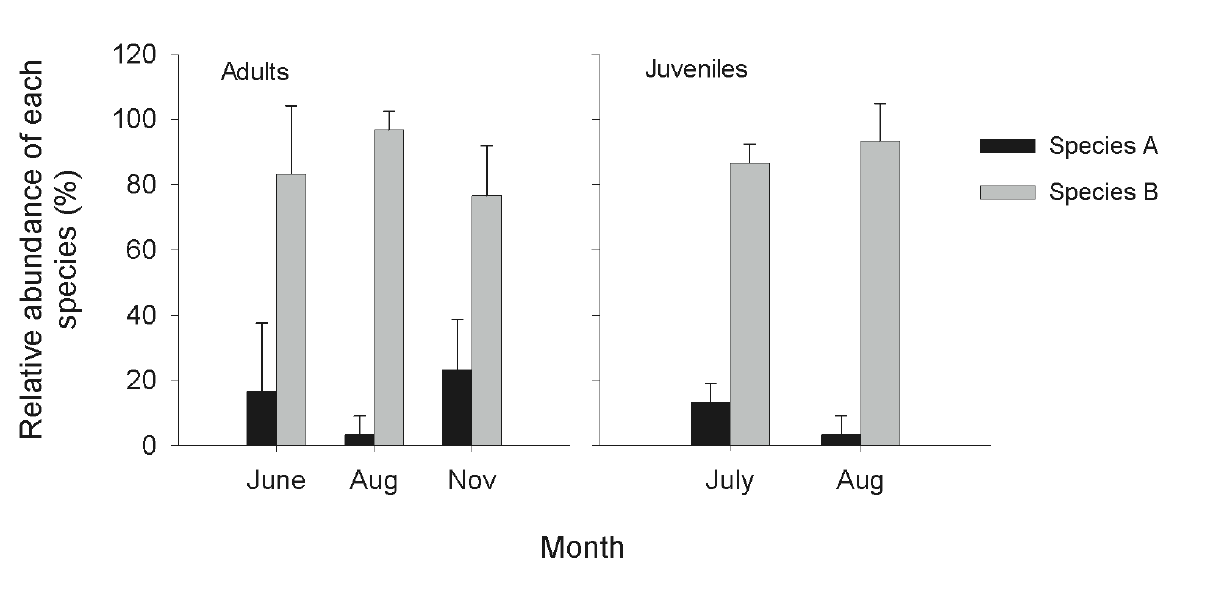
Figure 4. Monthly relative abundance of species A and B for adults and juveniles (mean ± standard deviation, number of replicates = 3 for each month).